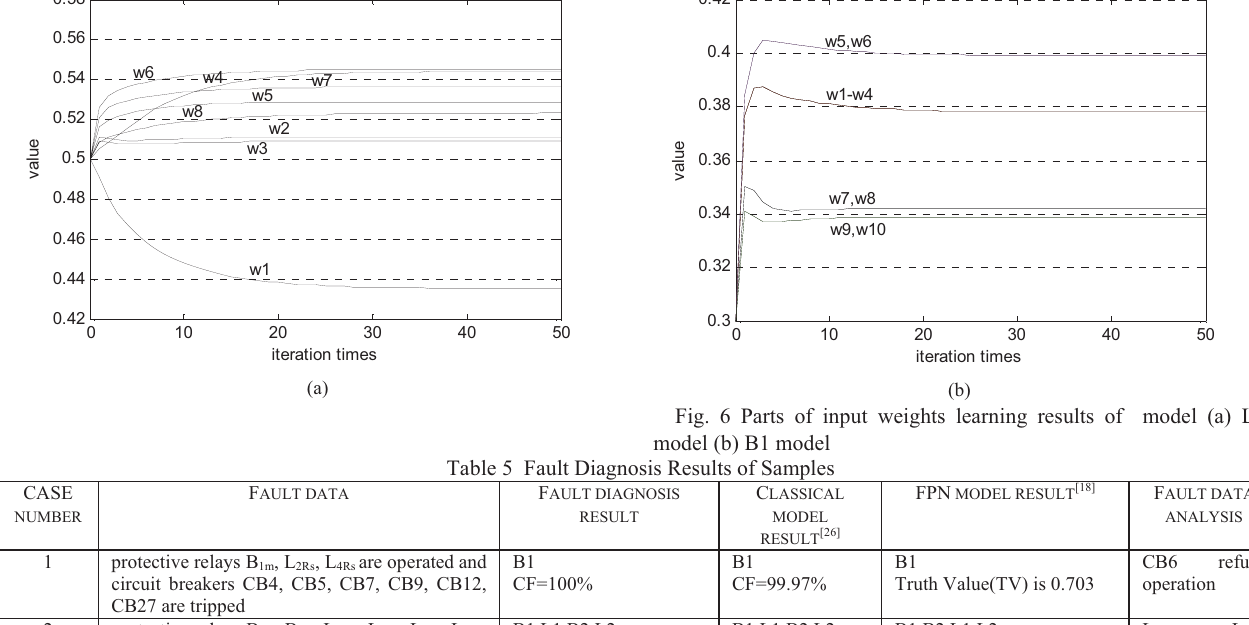
Table 5 Fault Diagnosis Results of Samples